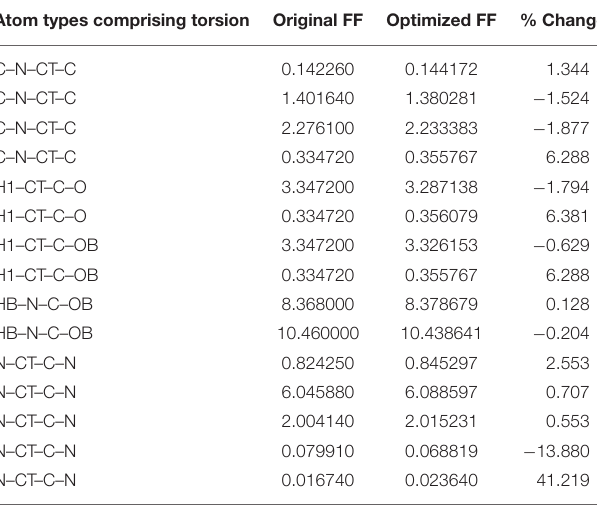
Refer to the Table 1 legend for an explanation of the atom